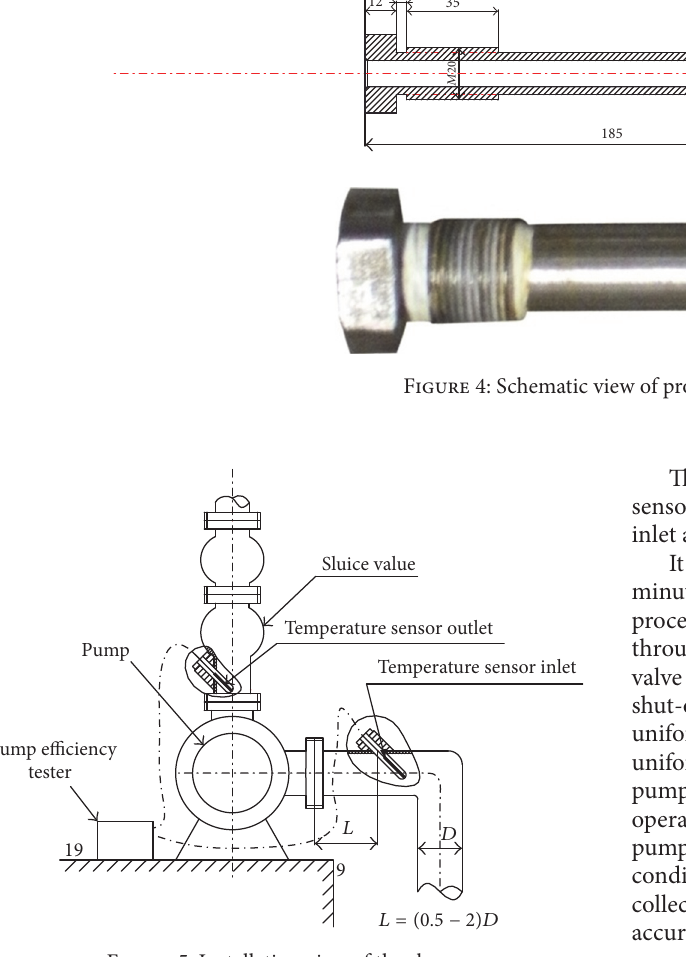
Figure 5: Installation view of the